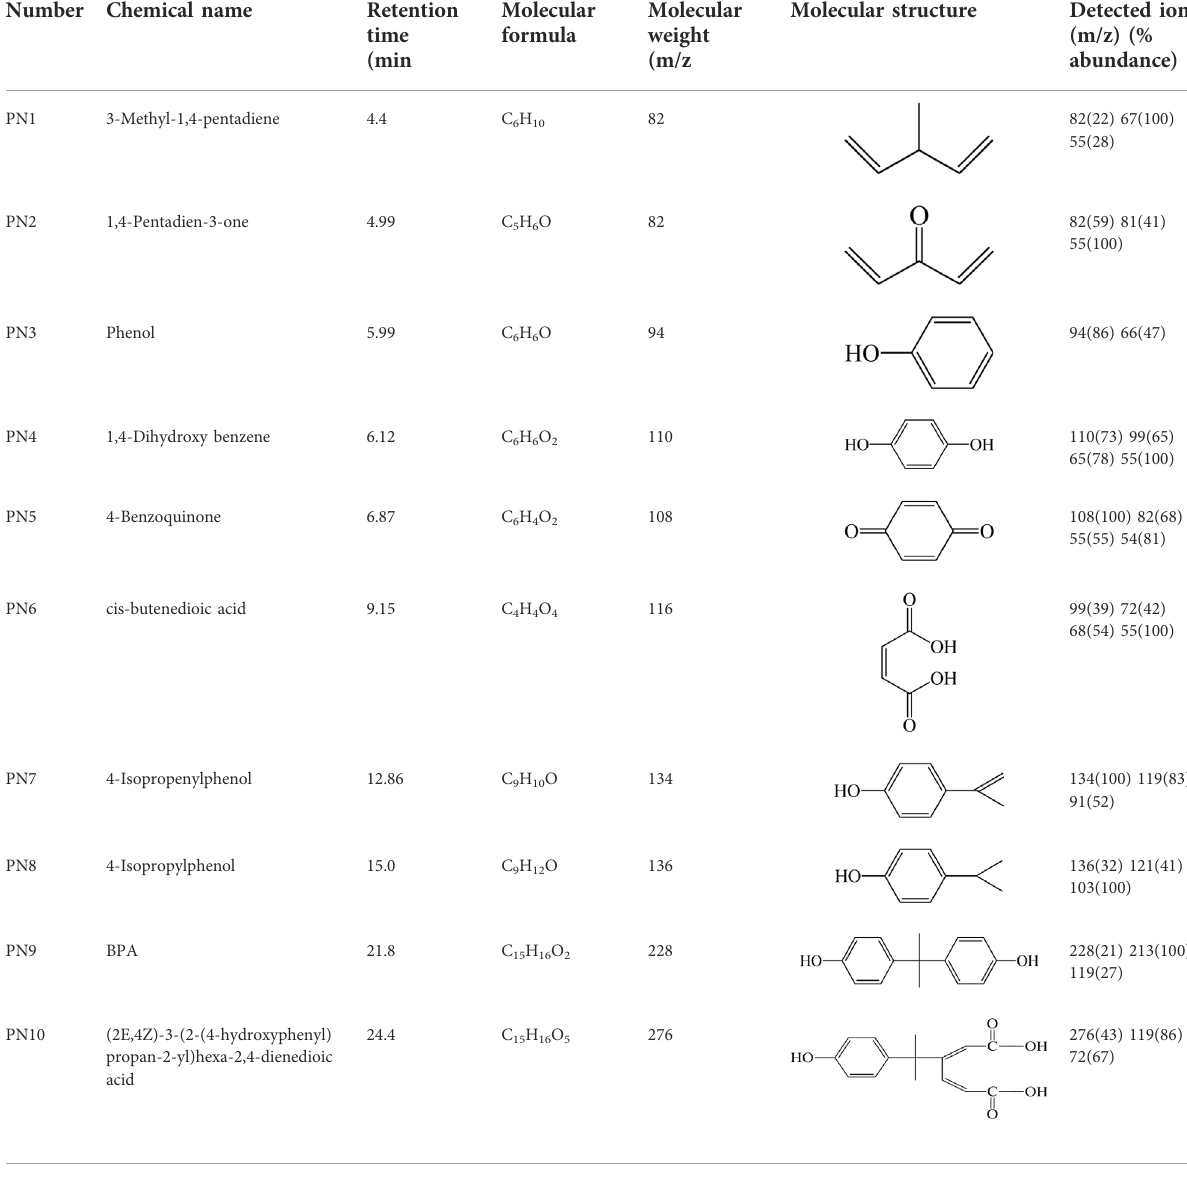
TABLE 1 Main fragment ions (m/z) and abundance (%) of reaction intermediates identi fi ed by GC/MS-MS.